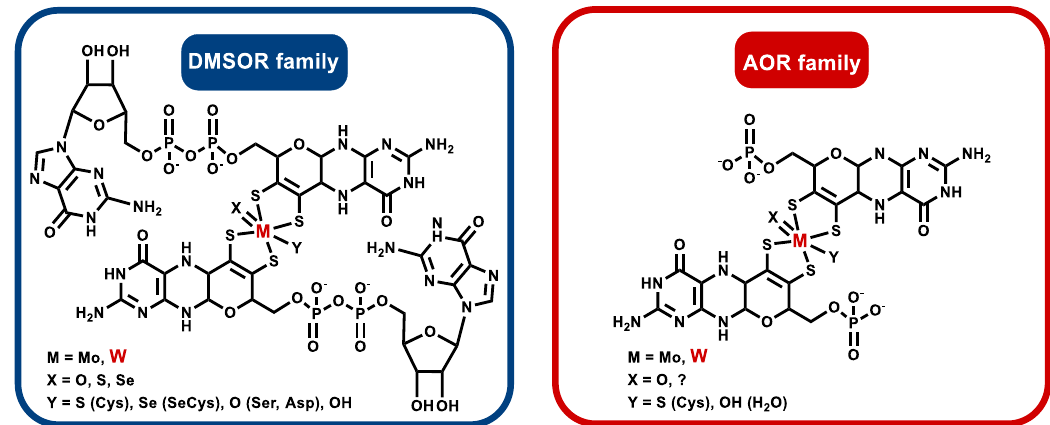
Figure 1. Tungsten cofactor (Wco) found in members of the dimethyl sulfoxide reductase (DMSOR) and aldehyde oxidoreductase (AOR) enzyme families. The former contains either Mo-bis-MPT guanine dinucleotide (MGD) or W-bis-MGD, the latter in most cases use W-bis-metallopterin (MPT) as the active site cofactor.